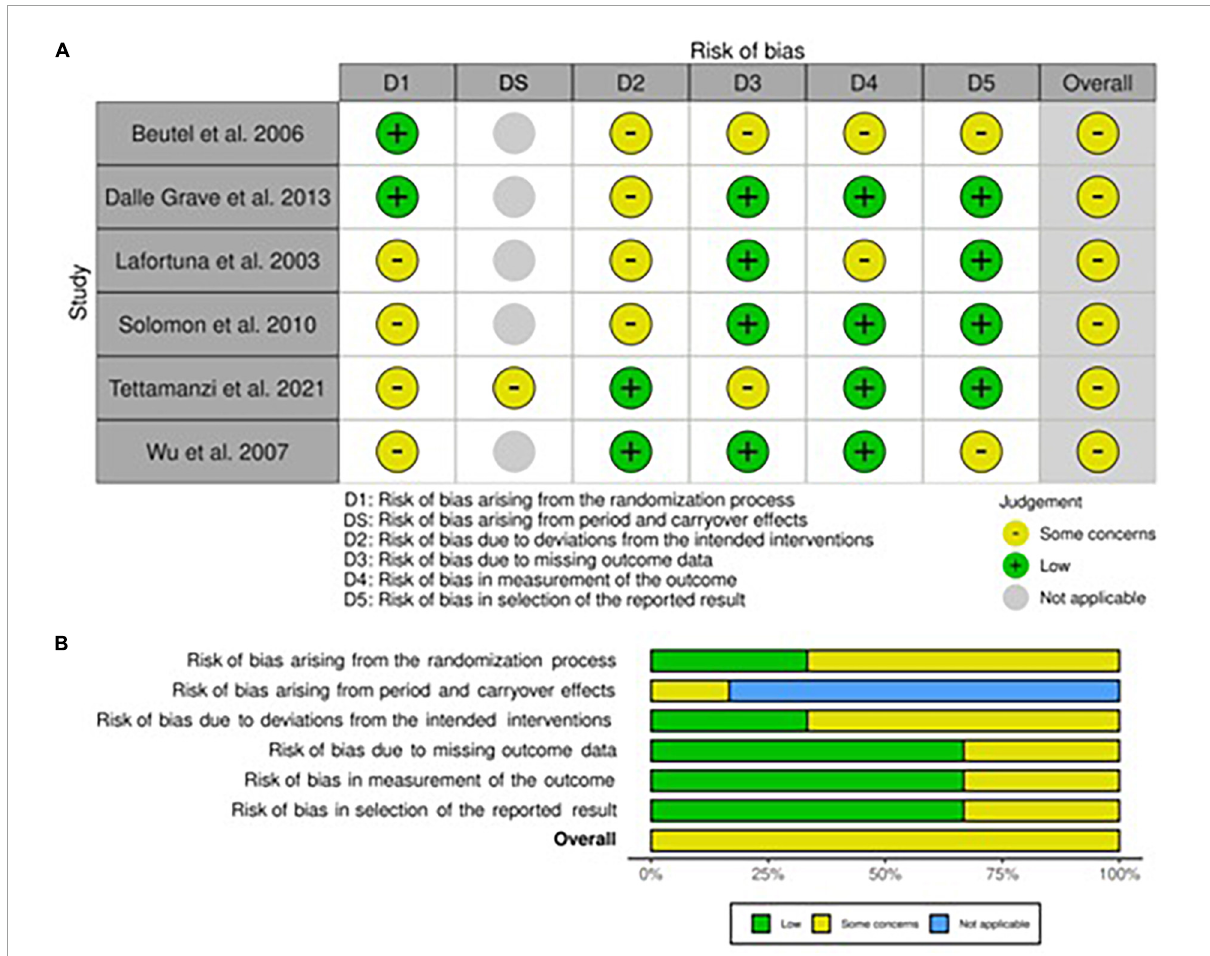
FIGURE4 Risk of bias within Randomized Controlled Trials (RCTs) in adults. (A) Traffic light plot and (B) summary plot presenting the risk of bias within the RCTs included in the systematic review.